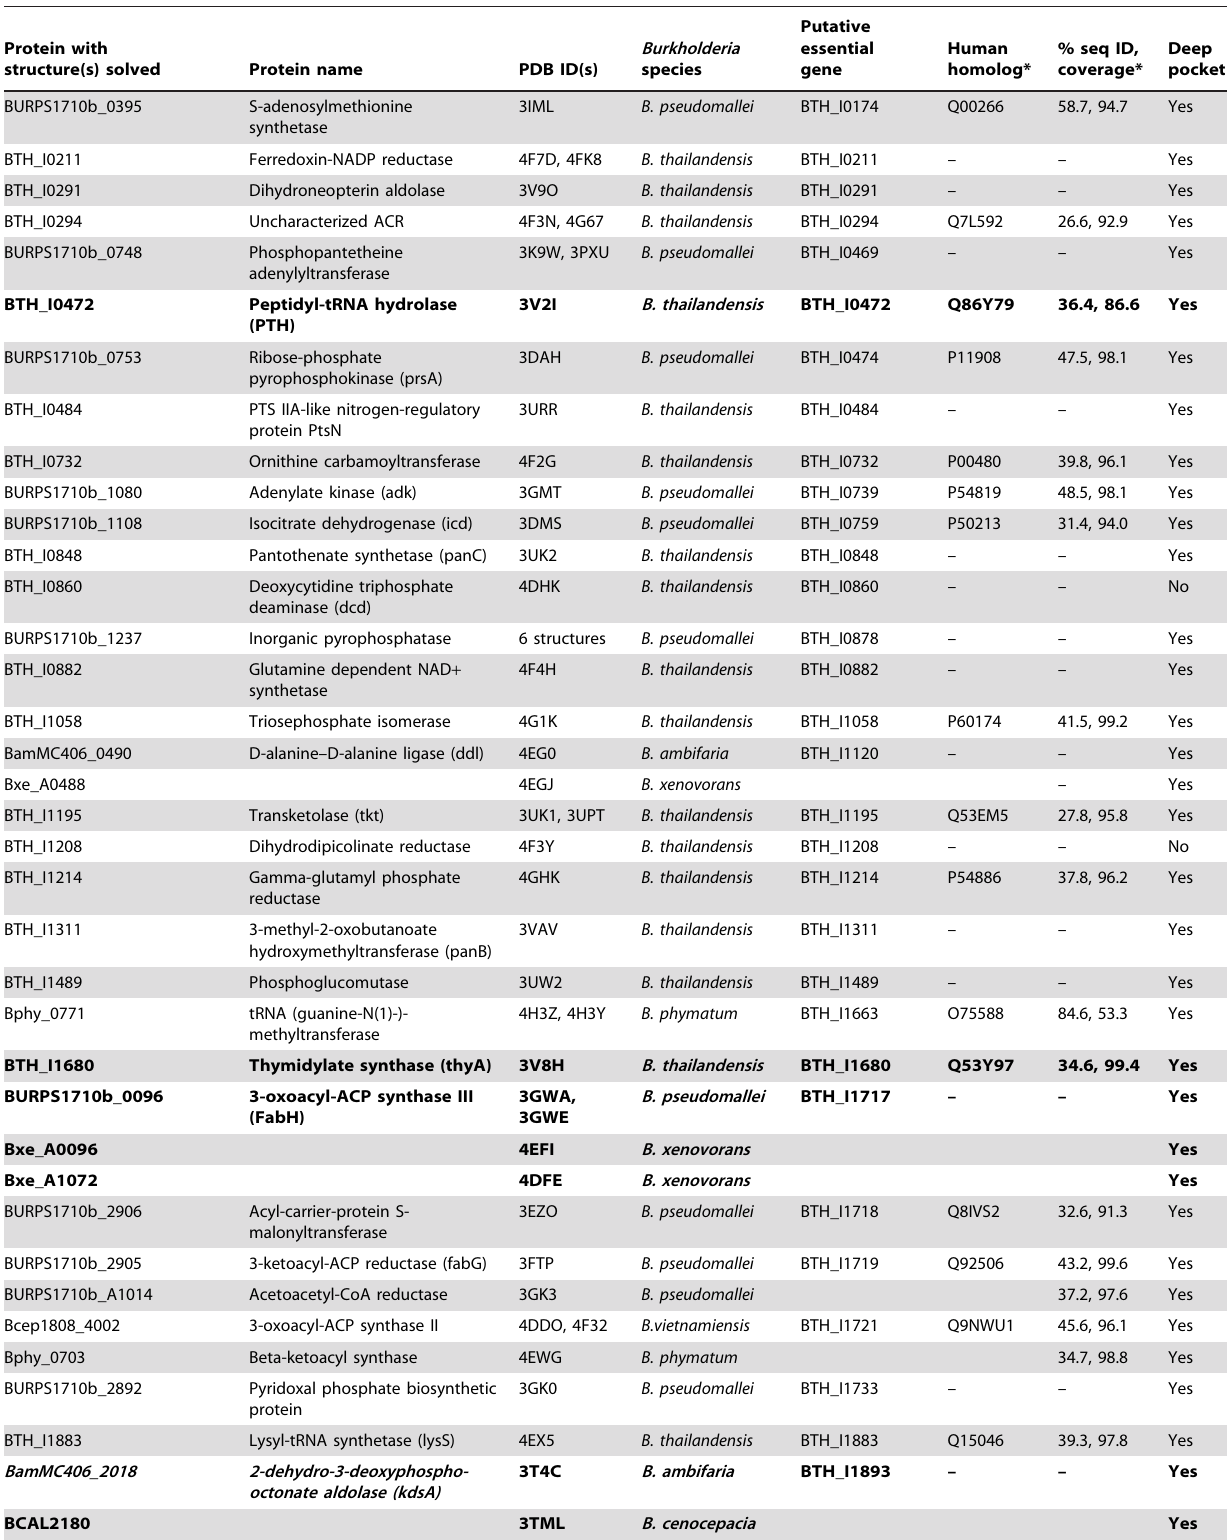
Table 3. Burkholderia protein structures.